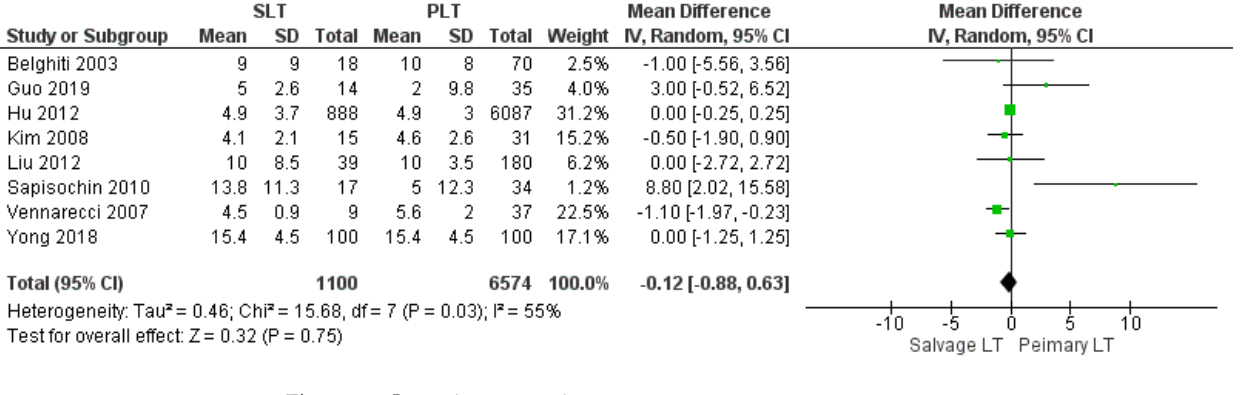
Figure 9. Postoperative bleeding.